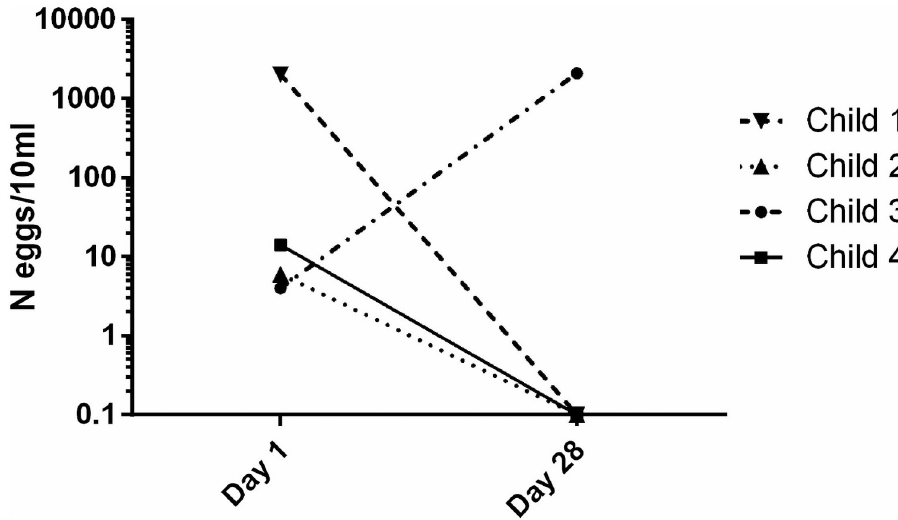
Fig 3. Observational study in Gabonese patients (step 4). Individual treatment response. Children excreting S . haematobium eggs were treated with pyronaridine-artesunate starting at day 1. After 28 days, urines were analyzed again and number of eggs/10 ml urine was reported.